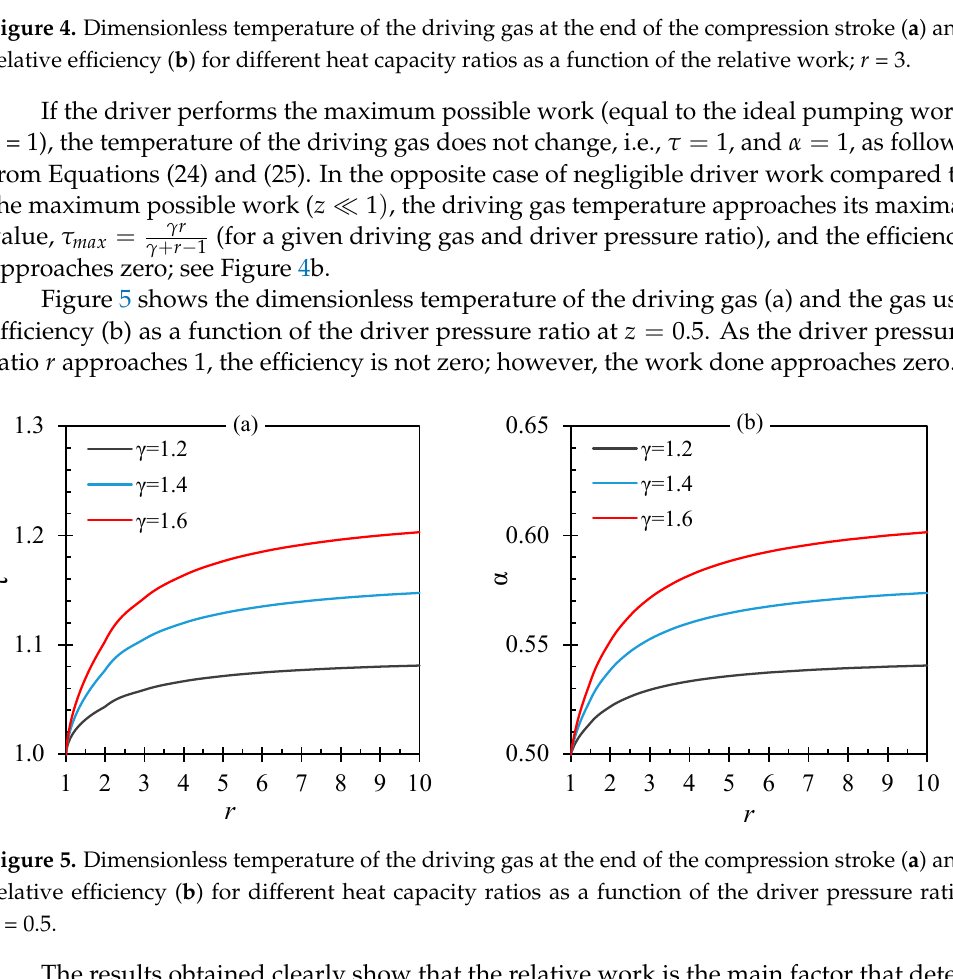
Figure 5. Dimensionless temperature of the driving gas at the end of the compression stroke ( a ) and relative efficiency ( b ) for different heat capacity ratios as a function of the driver pressure ratio; 𝑧 = 0.5.